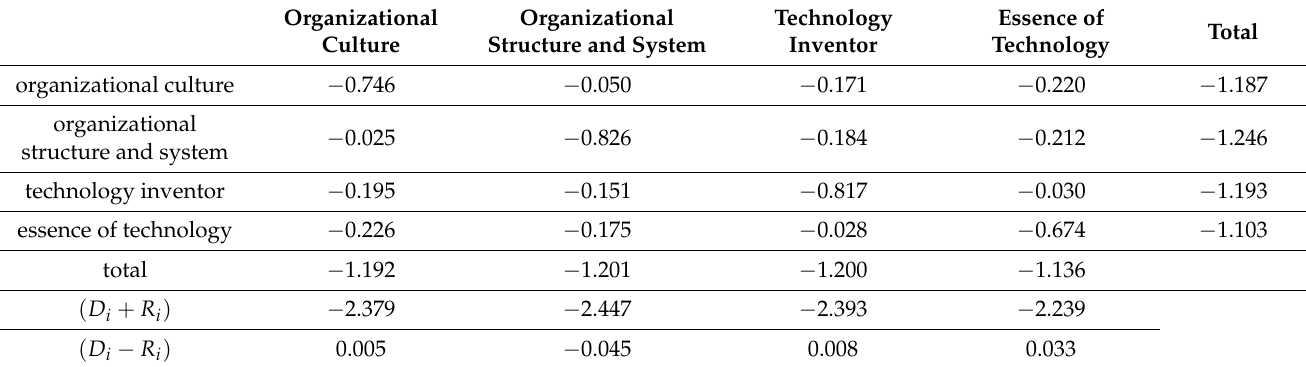
Table 2. The causal matrix of main